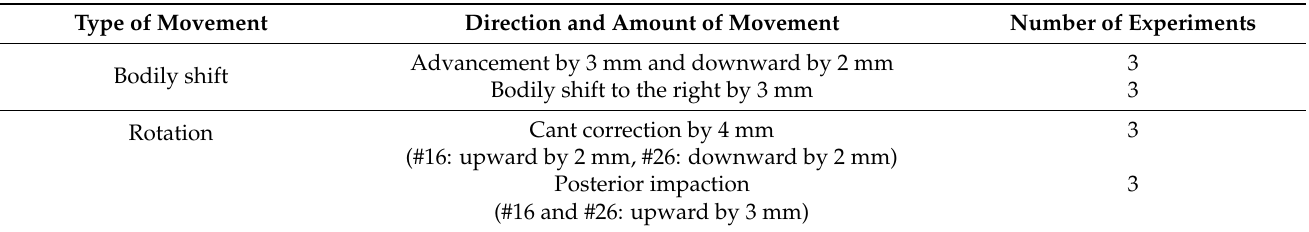
Table 1. Description of different surgical plans implemented in this study. Type of Movement